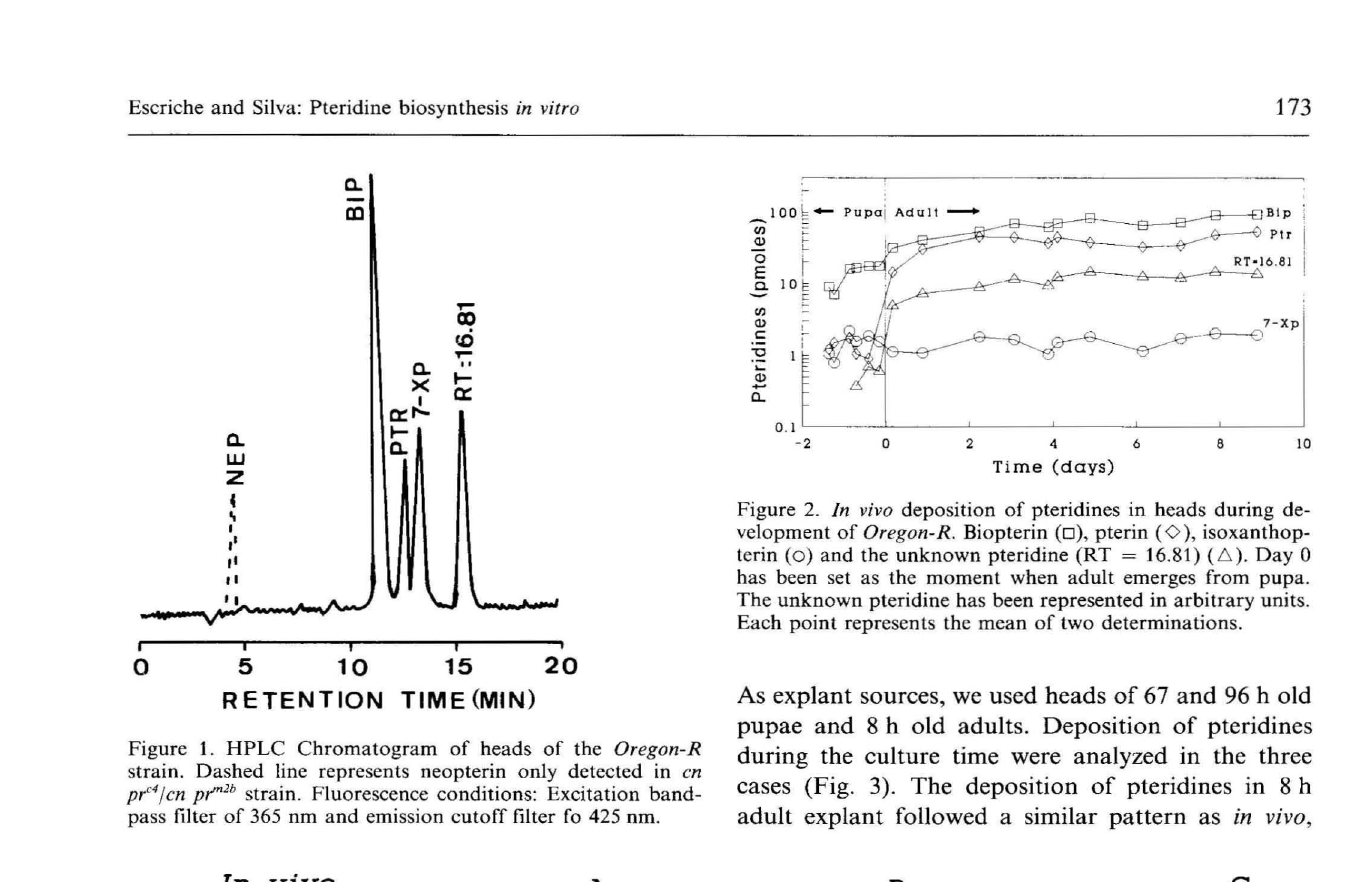
Figure 1. HPLC Chromatogram of heads of the Oregon-R strain. Dashed line represents neopterin only detected in en p,-c4/en pr'"2h strain. Fluorescence conditions: Excitation band pass filter of 365 nm and emission cutoff filter fo 425 nm.